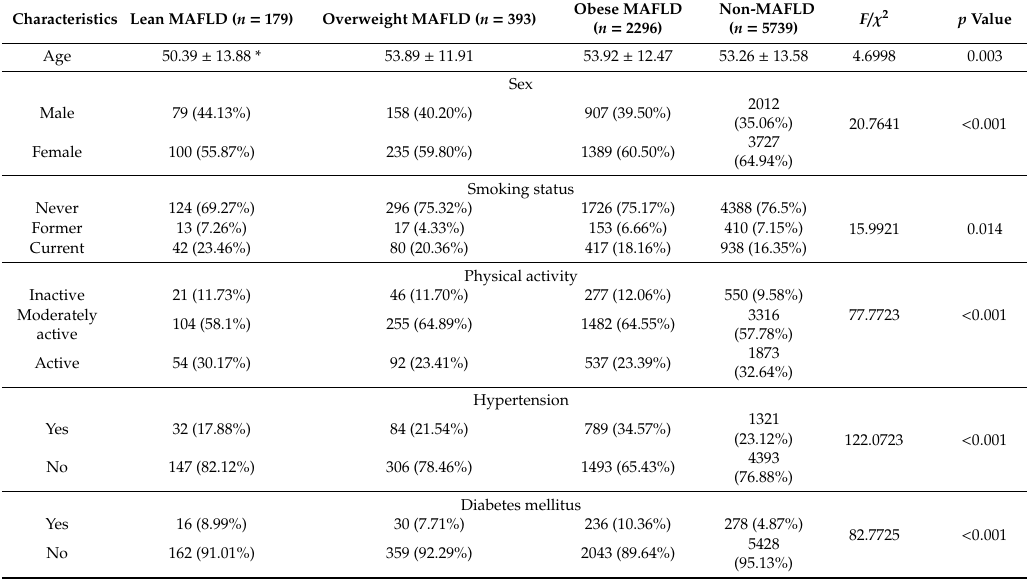
Table 5. Clinical characteristics of participants with MAFLD groups versus control